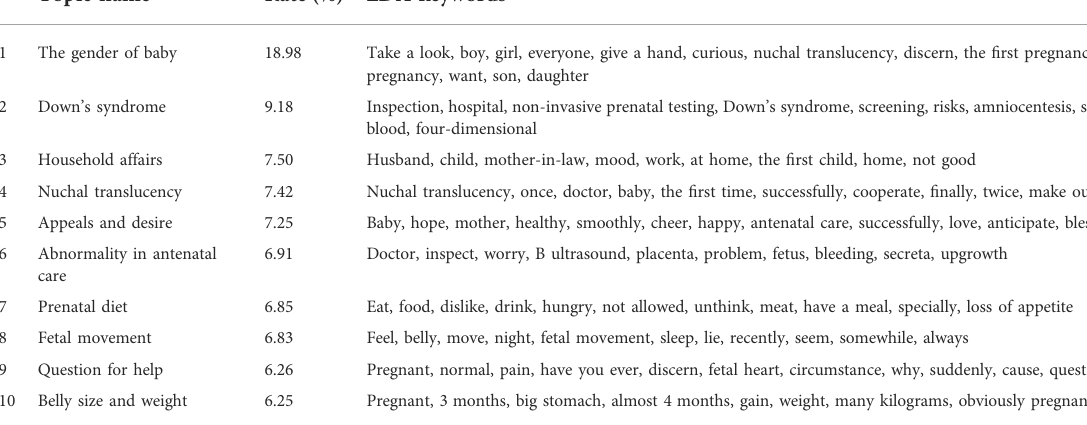
TABLE 7 Topics in the fourth month of